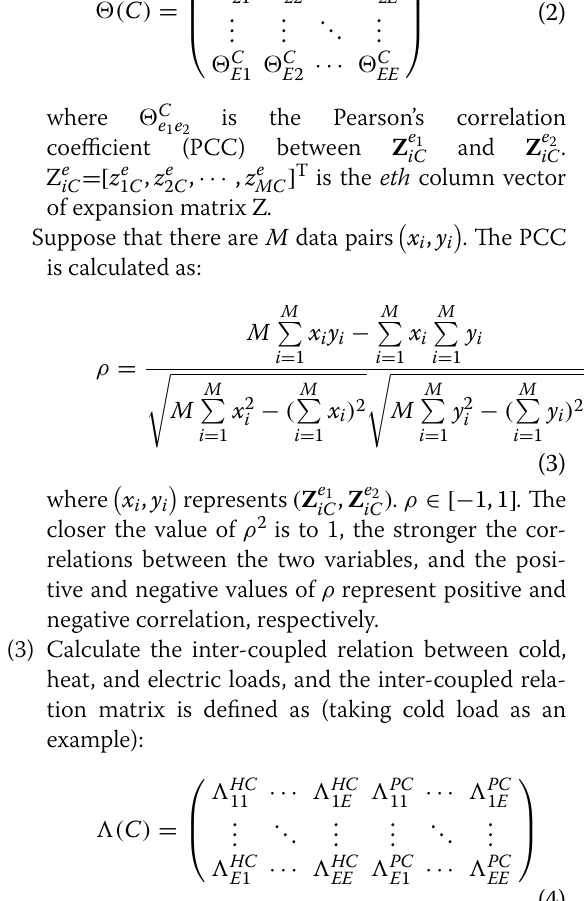
A load forecasting model based on LSTM-MTL is pro- posed to learn the complex coupling information between cold, heat, and electric load forecasting